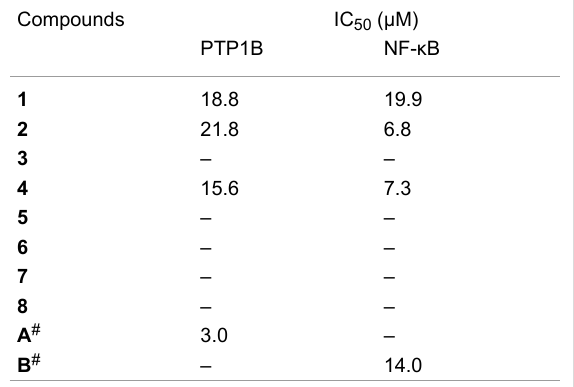
Table 3: PTP1B and NF- κ B inhibitory effect of compounds 1 – 8 .